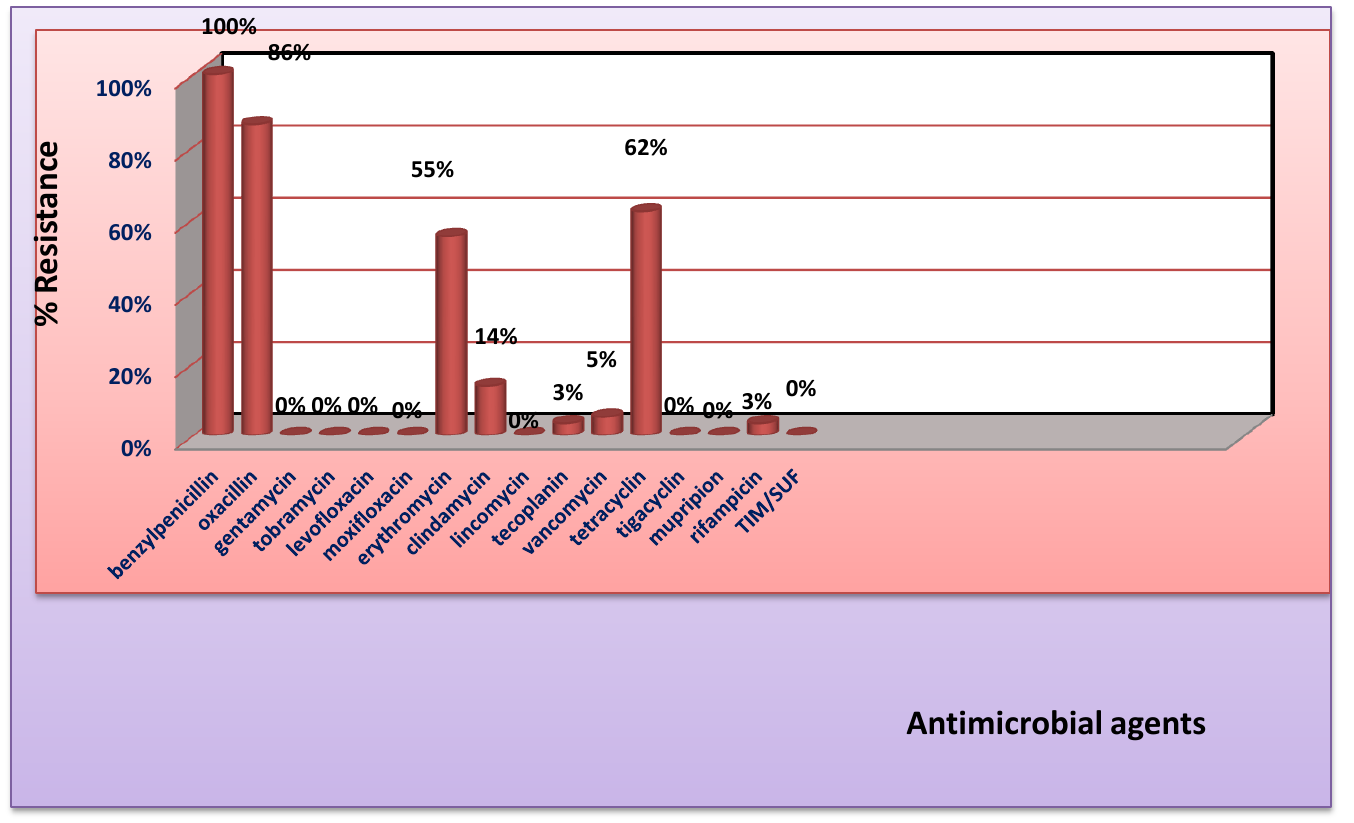
Figure (1): Resistant S. aureus isolates to antimicrobial agents (n=58) Table (1): Effect of T. Foenum- groecum essential oils and Clindamycin alone and in combination with each other on MDR S. aureus isolates